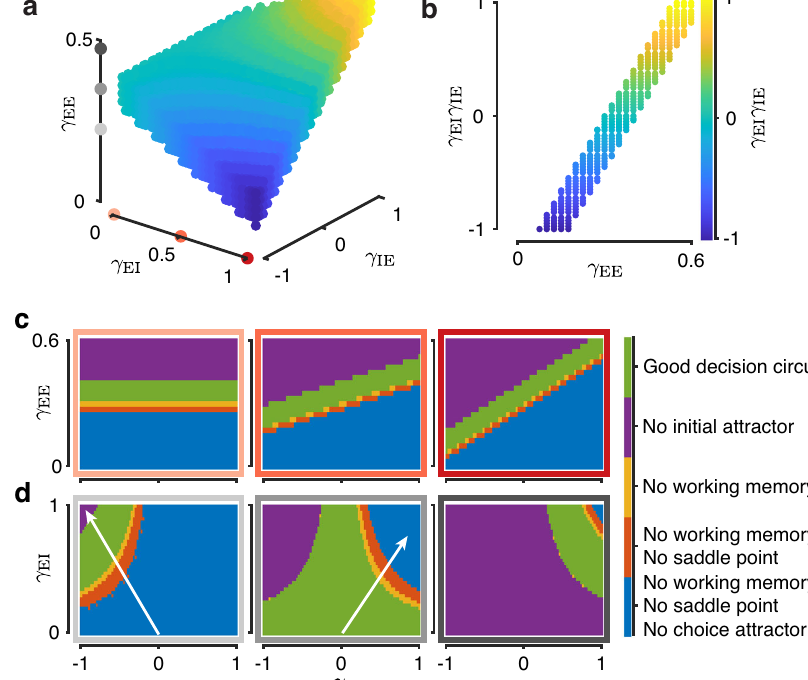
Fig. 2 | Choice-selective inhibition expands the space of circuits supporting broaderrangeof γ EE cansupportdecisionmaking,evidentasasteeperslopeofthe decision making. a The volume in the connection speci fi city parameter space region with all required fi xed points (green, good decision circuit). Panels show where circuits have all fi xed points necessary to support decision-making. Color slices through the parameter space in a at γ EI =0.0 (left), γ EI =0.5 (center), γ EI =1.0 indicates the inhibitory speci fi city index γ EI γ IE . b For nonselective or nonspeci fi c (right). Colored frames correspond to dots on the γ EI axis in a . d When γ EE is low inhibition, circuits that support decision-making exist only for a narrow range of inhibition must be contraspeci fi c (left) and when γ EE is high inhibition must be γ fi c, a broader range of γ ipsispeci fi c (right). Slices through the parameter space in a at γ EE =0.225 (left), EE . If inhibition is selective and speci EE becomes possible. γ γ Inhibitory speci fi city needs to be complementary to excitatory speci fi city, as EE =0.35(center), EE =0.475(right).Coloredframescorrespondtodotsonthe axis in a . Arrows indicate a sequential loss of fi xed points described in the re fl ected in the correlation between the inhibitory speci fi city index and γ EE for circuits with all necessary fi xed points. c With increasing inhibitory selectivity, a